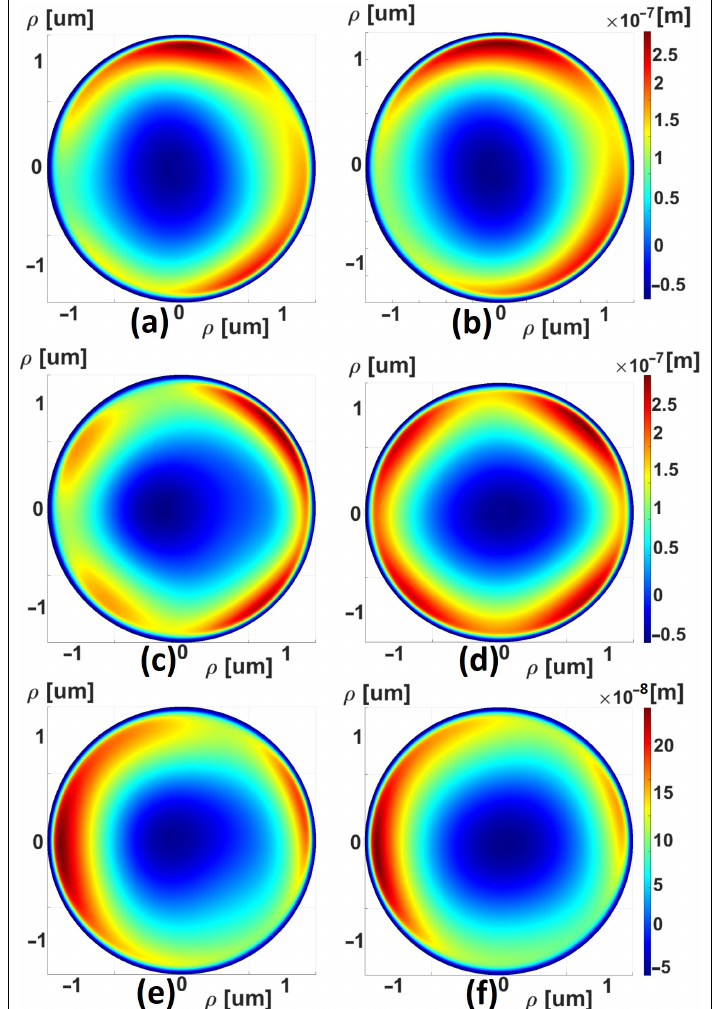
Figure 7. Obtained wavefronts W ( ρ , θ ) by a M = 30-degree fitting from Equation (8) in ( a , c , e ) of the SGR in the simulated LCD, from experimental data of L1, L2, and L3 respectively. In ( b , d , f ), we show the fits to the software and hardware data ZYGO/APEX of the same lenses L1, L2, and L3,